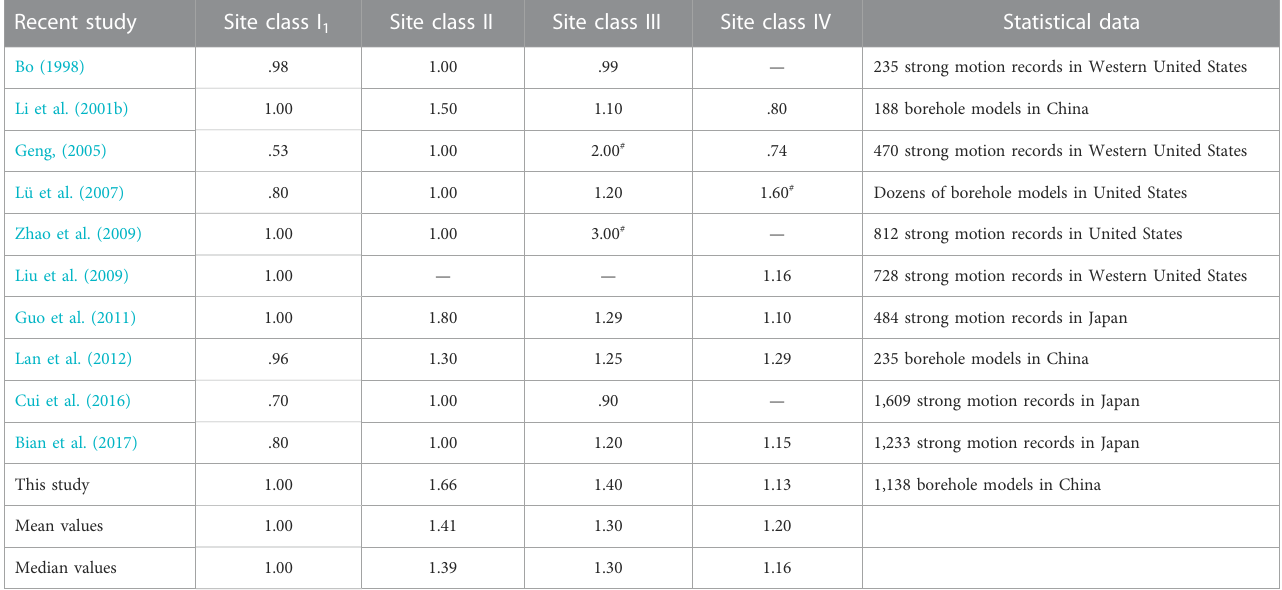
Figure 3 scaled by PGA = .5, .75, 1.0, 1.5, 2.0, 3.0, 4.0, 5.0, and 6.0 m/s − 2 .